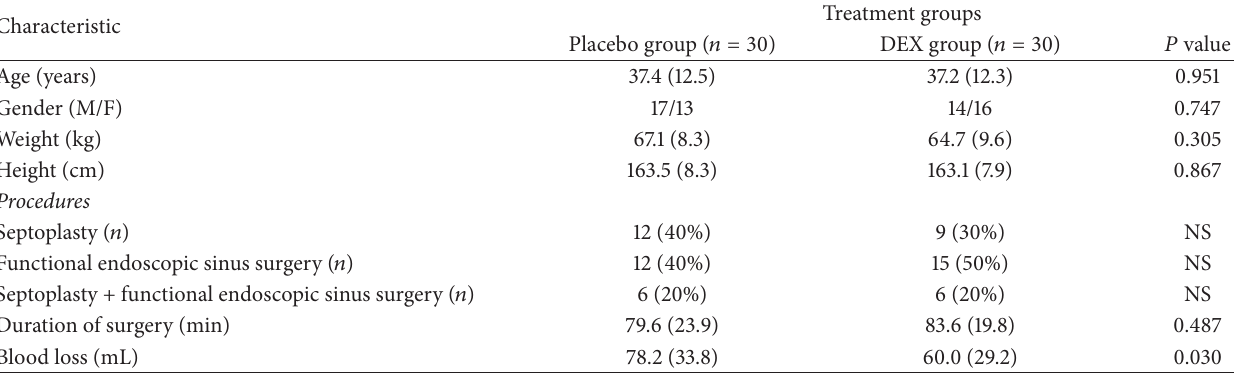
Table 1: Subject and procedure characteristics.